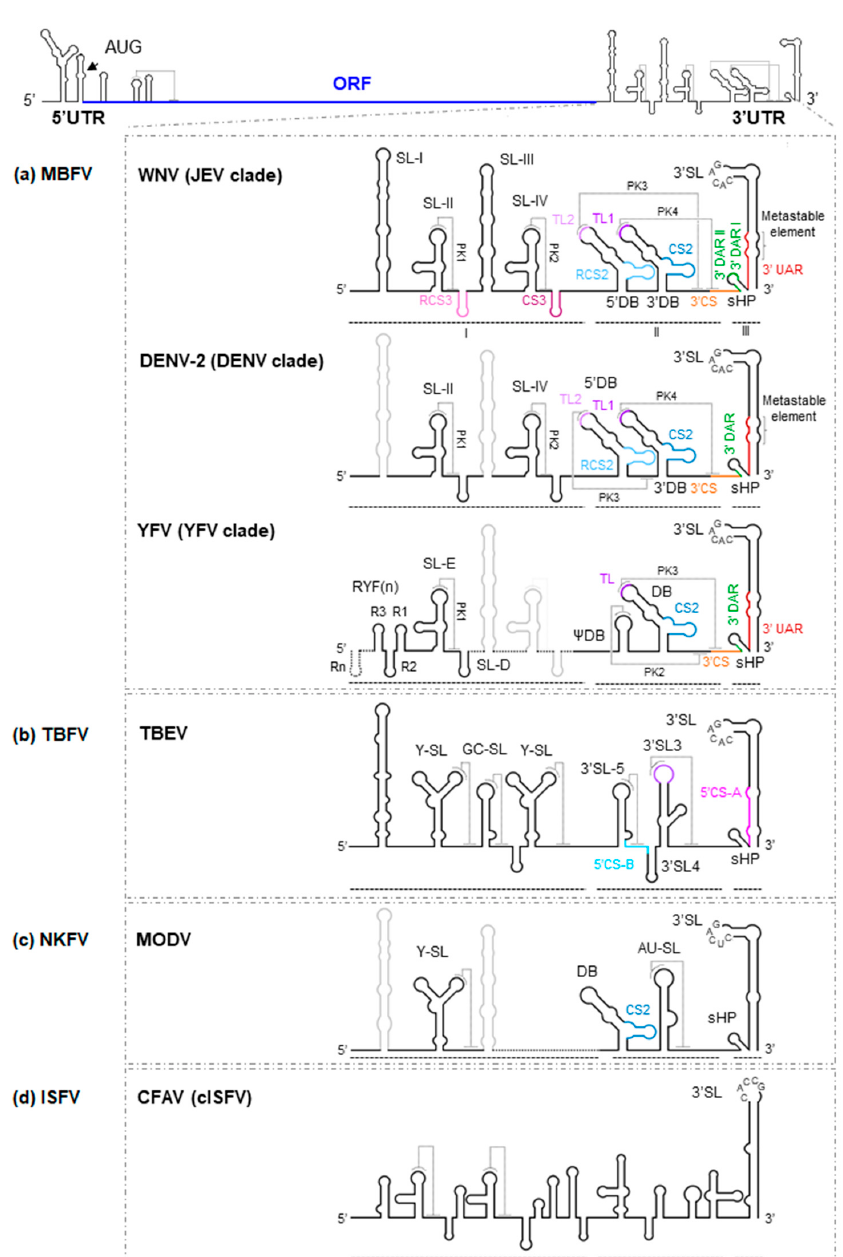
Figure 2. Secondary structure model of the 3 ′ UTR of flavivirus genomes. As a model for flaviviruses, a diagram of the WNV genome is shown at the top of the figure. Below are detailed representations of the secondary structure of the genomic 3 ′ UTR, indicating the identified secondary structural elements, the tertiary interactions and sequence motifs, for ( a ) WNV, DENV-2 and YFV, all members of the MBFV group; ( b ) TBEV, representative of the TBFV group; ( c ) MODV, a member of the NKFV group; and ( d ) CFAV, a member of the ISFV group. Secondary structural elements of each virus are indicated (thick black lines) on the secondary structure model of the WNV background (thick grey lines); note the differences between them. Structural elements and sequence motifs are named. Sequence motifs involved in genome cyclization (UAR, DAR and CS) are indicated by colored lines (same key as in Figure 1) to designate corresponding sequence partners in both figures. Dotted lines indicate interactions involved in the formation of pseudoknot structures. Thick dotted lines in the representation of YFV secondary structure indicate the presence of extra RYF elements in other members of the YFV clade.